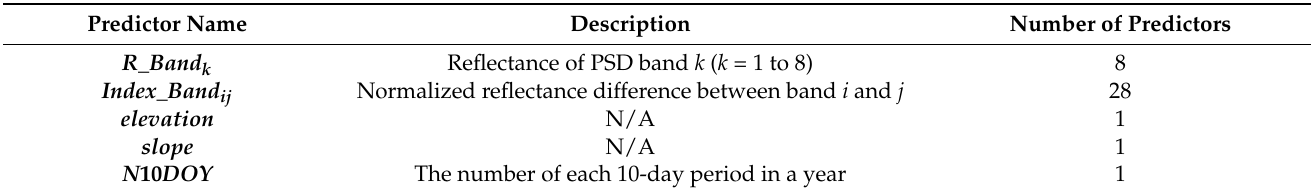
Table 1. Summary of the 39 predictor variables used for ML-based SSM